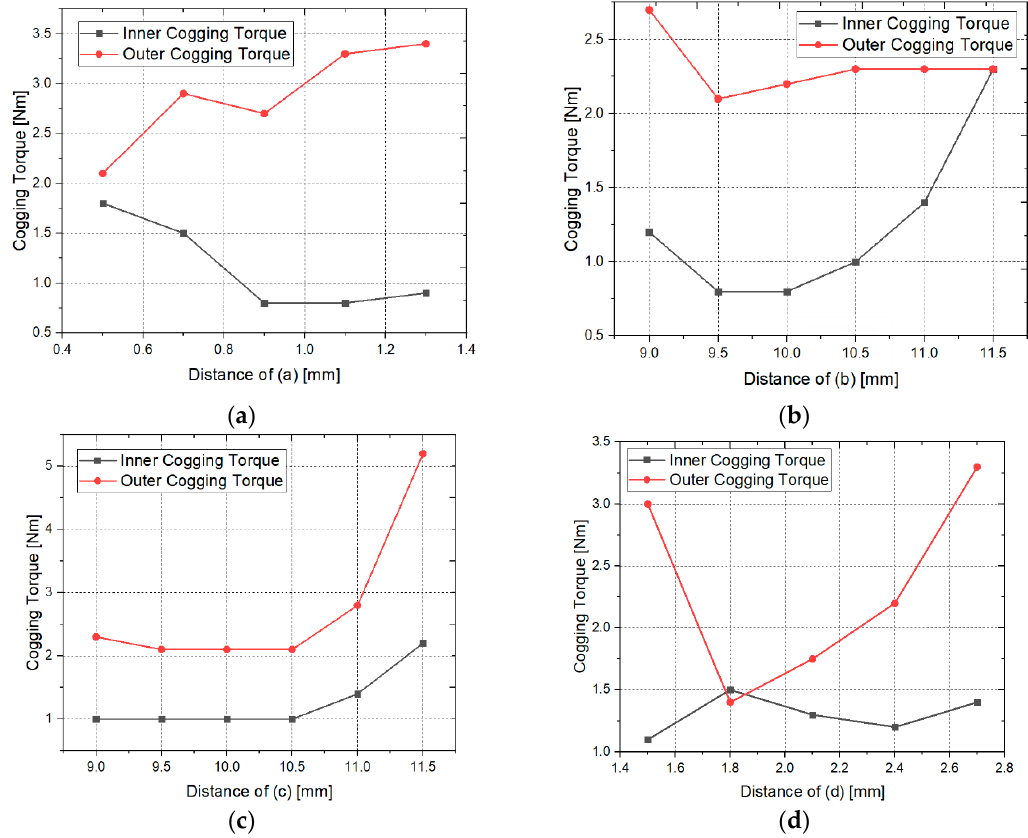
ff erent spots for the distance parameter. Figure 7. Four different spots for the distance parameter. Figure 7. Four di